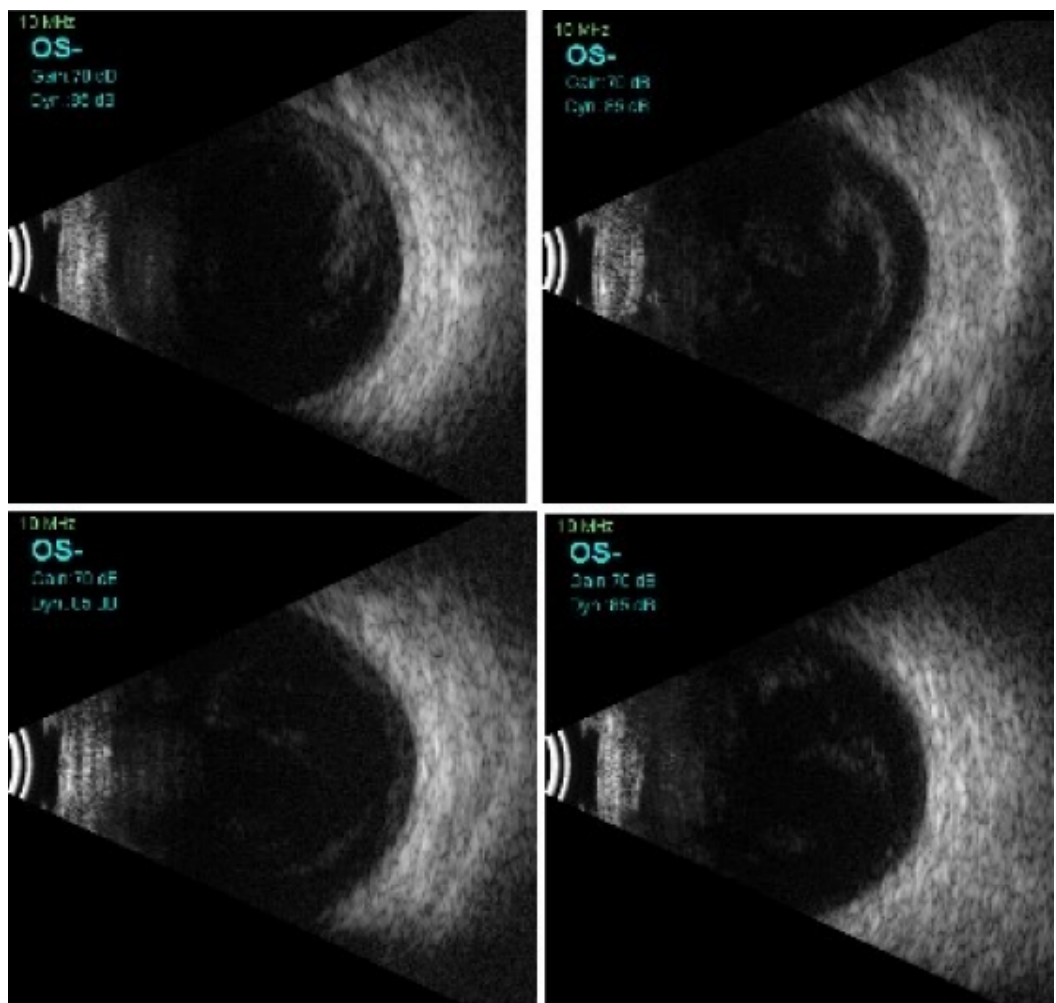
Figure 1: Transverse B-scan of all quadrants showing medium reflective dot and clump echoes in all quadrants in vitreous cavity